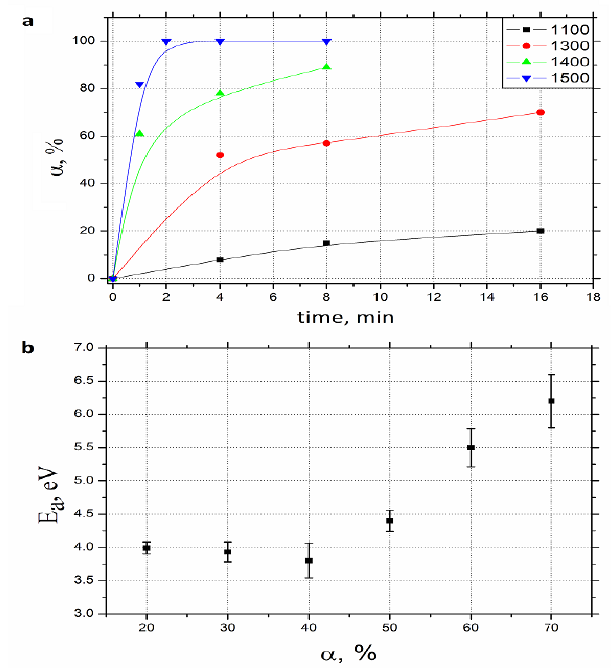
Figure 2. The dependences of the reaction (2) kinetic parameters: the degree of conversion α on time ( a ), and the activation energy (E a ) on α ( b ).